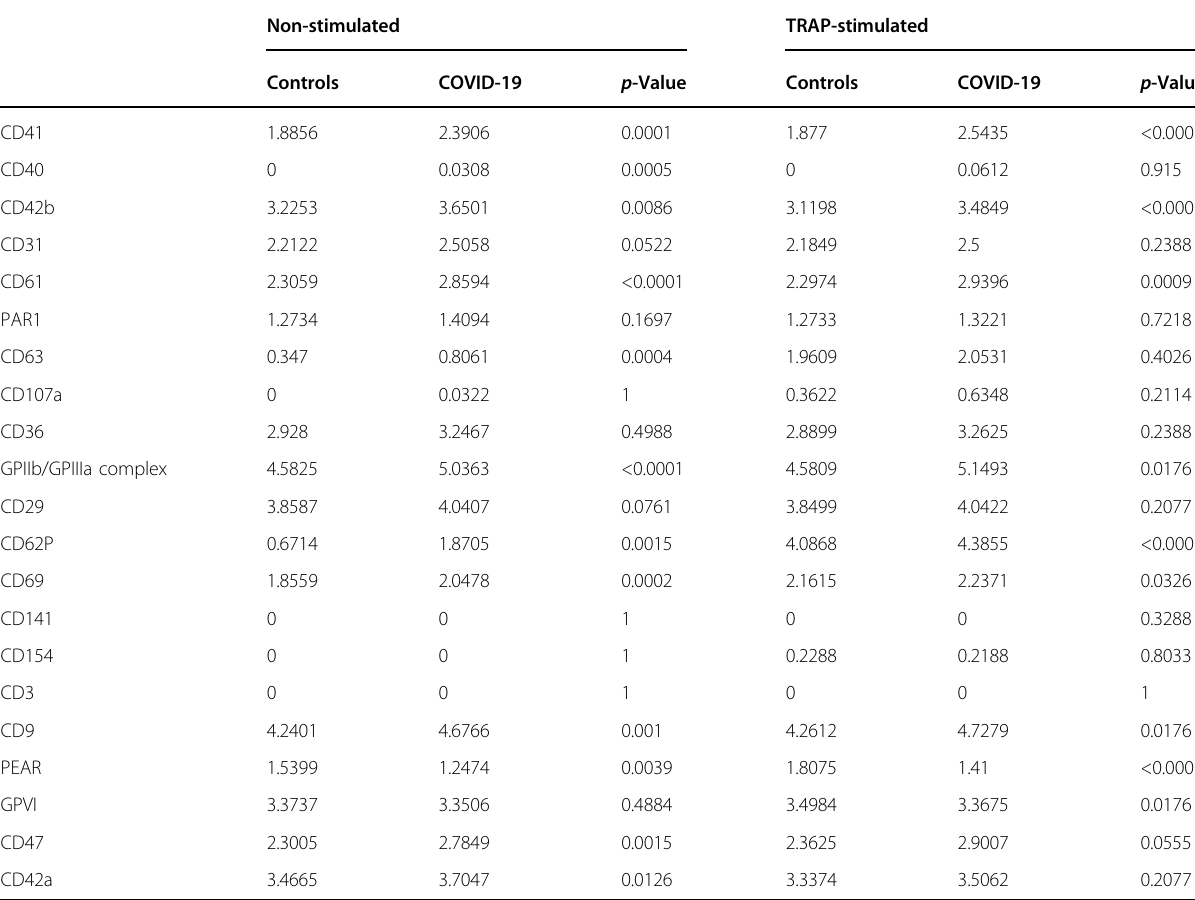
Table 2 Median signal intensity and p -values of CyTOF